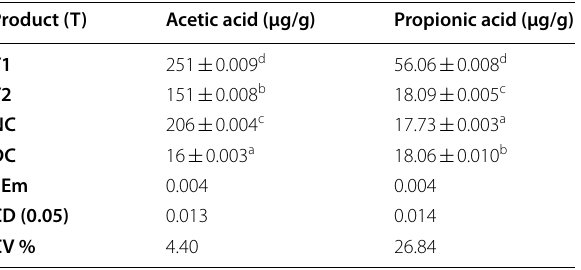
PFM Probiotic fermented